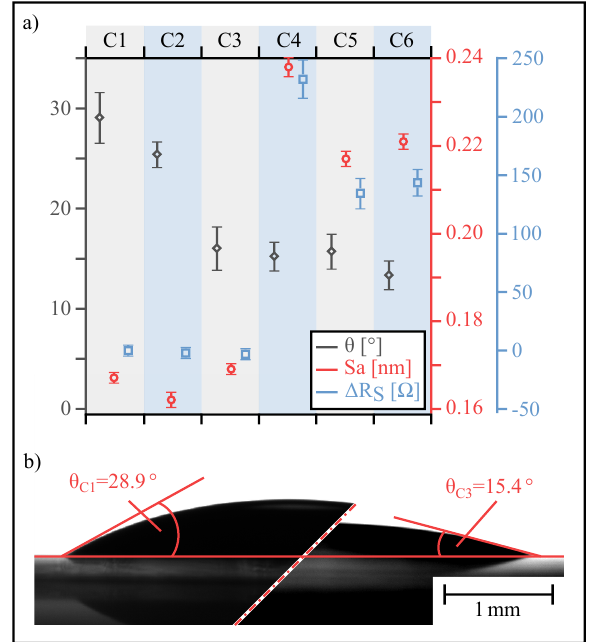
Figure 5. ( a ) Experimental characteristics of six differently treated substrates. Grey rhombs = contact angles, red circles = surface roughness and blue squares = difference in sheet resistance relative to untreated substrate. Each column represents one specific treatment. Left to right: column 1 (C1) untreated, C2 baked for 10min, C3 baked for 10min and coated with TiPrime, C4 RIE with O 2 (100%, 5min, 30W), C5 RIE with O 2 /CF 4 (25% O 2 /75% CF 4 , 5min, 30W), C6 analogue C5 and coated with TiPrime. ( b ) Picture of contact angle measurement. Left, contact angle of an untreated substrate (C1). Right, contact angle of a substrate baked for 10min. and coated with TiPrime